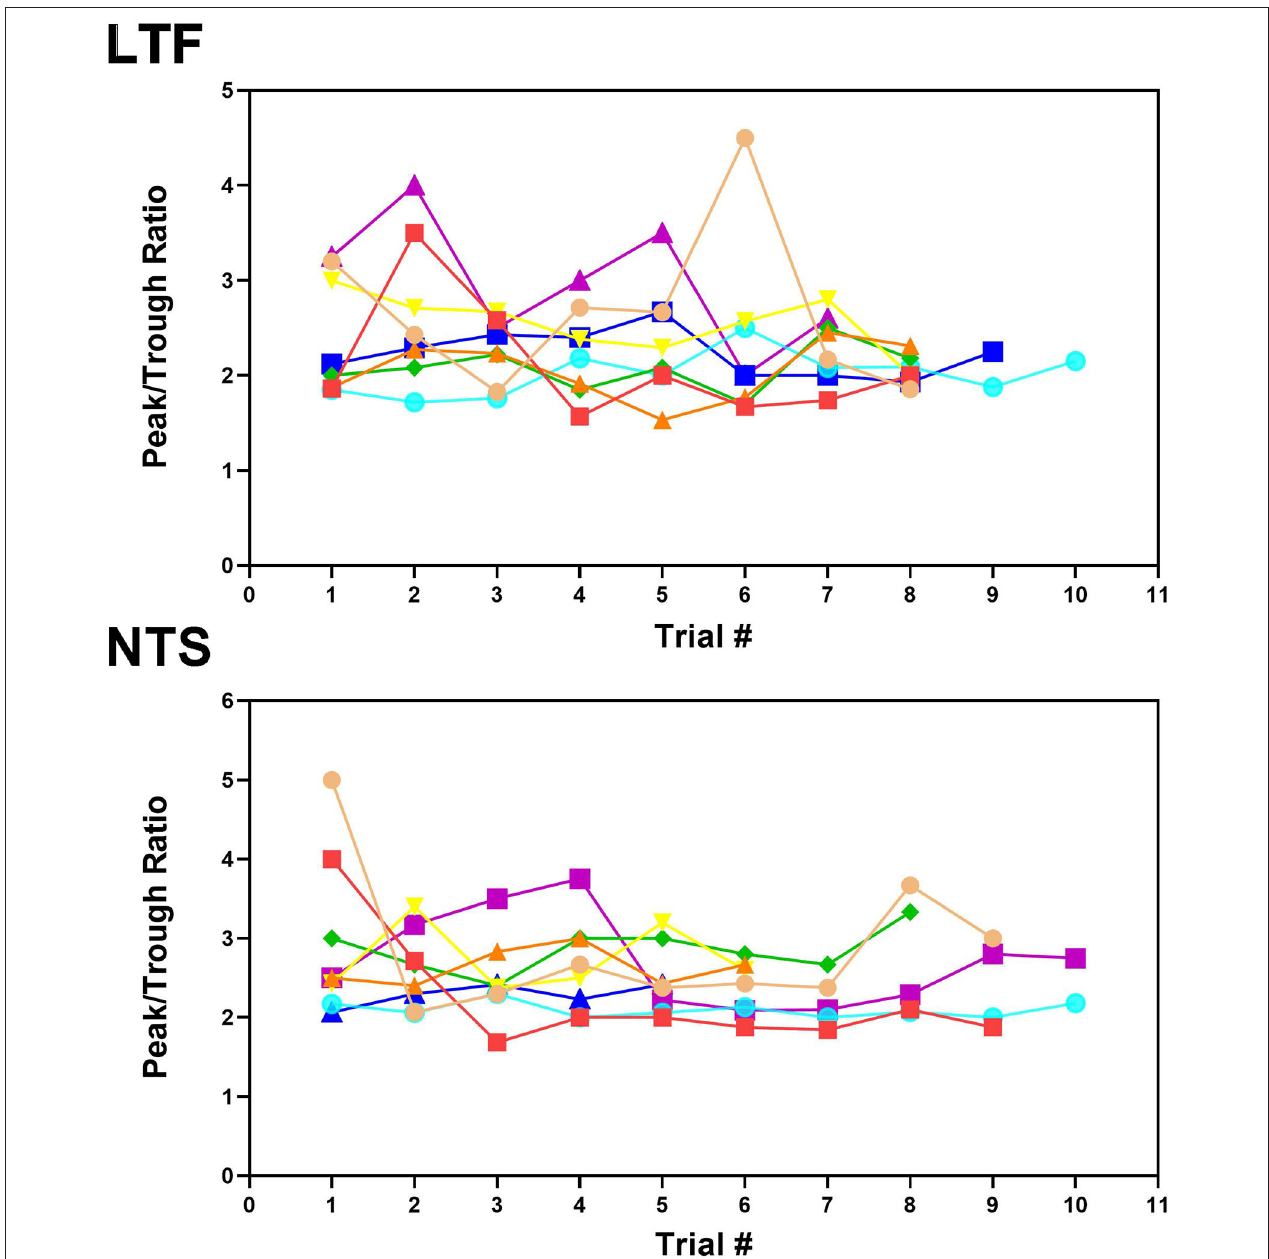
FIGURE 4 | Peak-to-trough ratio of activity related to the cardiac cycle for 8 LTF and 8 NTS units where multiple trials were conducted. Data for each unit is depicted by different shapes and colors. For most units, the peak-to-trough ratio varied throughout the course of recording although all units exhibited CRA during every trial.